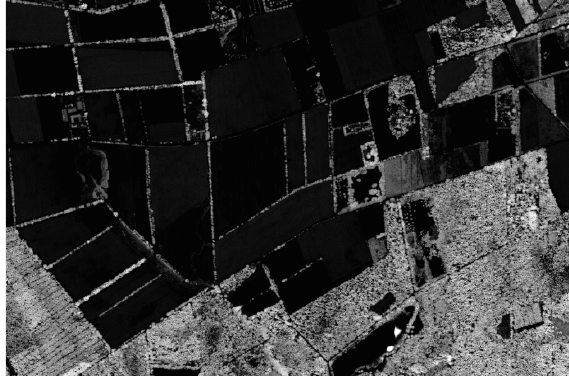
Figure 10. LIDAR-derived DSM showing all vegetation as grey pixels whose brightness increases with height above ground.